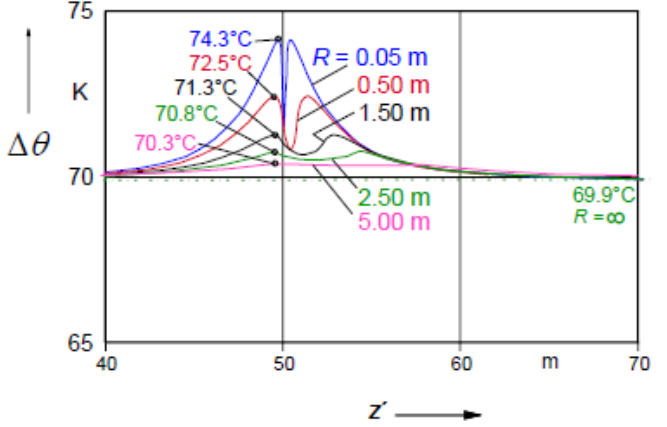
Figure 10. Temperature rise of a point 0.05 m below the line source ( y = 2.05 m) with a bending radius R ; losses (p.u.l.) W ′ = 100 W/m.